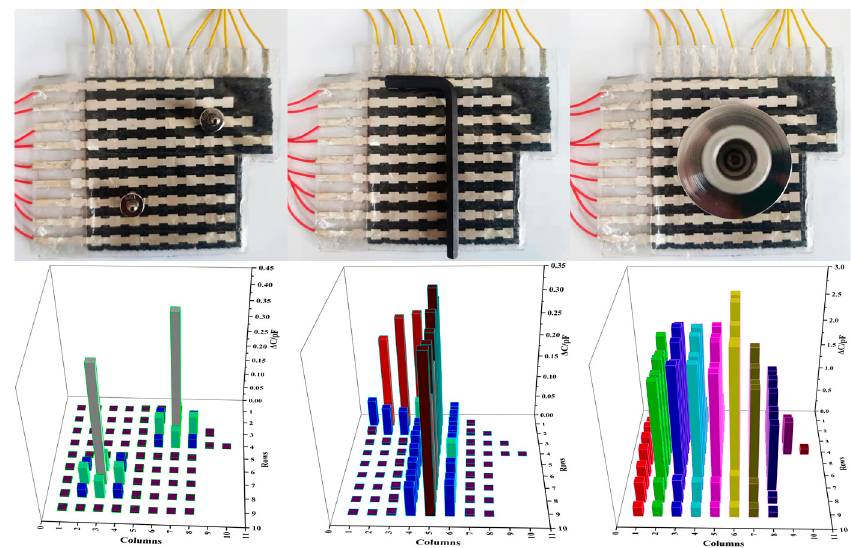
Figure 11. Shape perception of different objects by pressure sensor array.